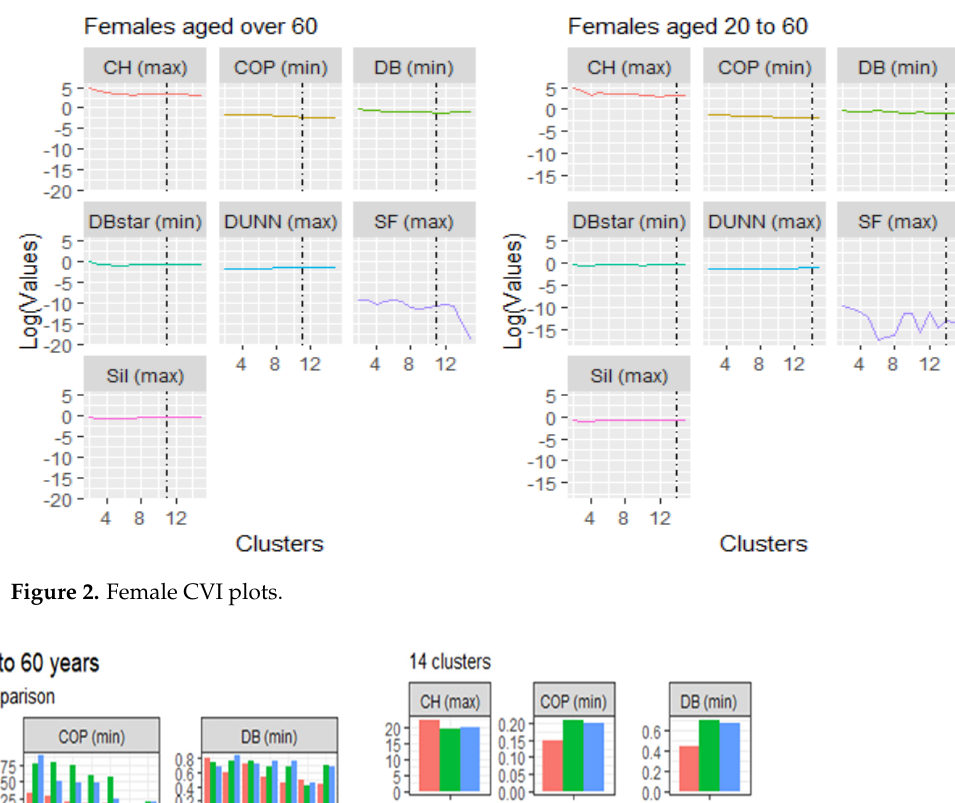
Figure 2. Female CVI plots.